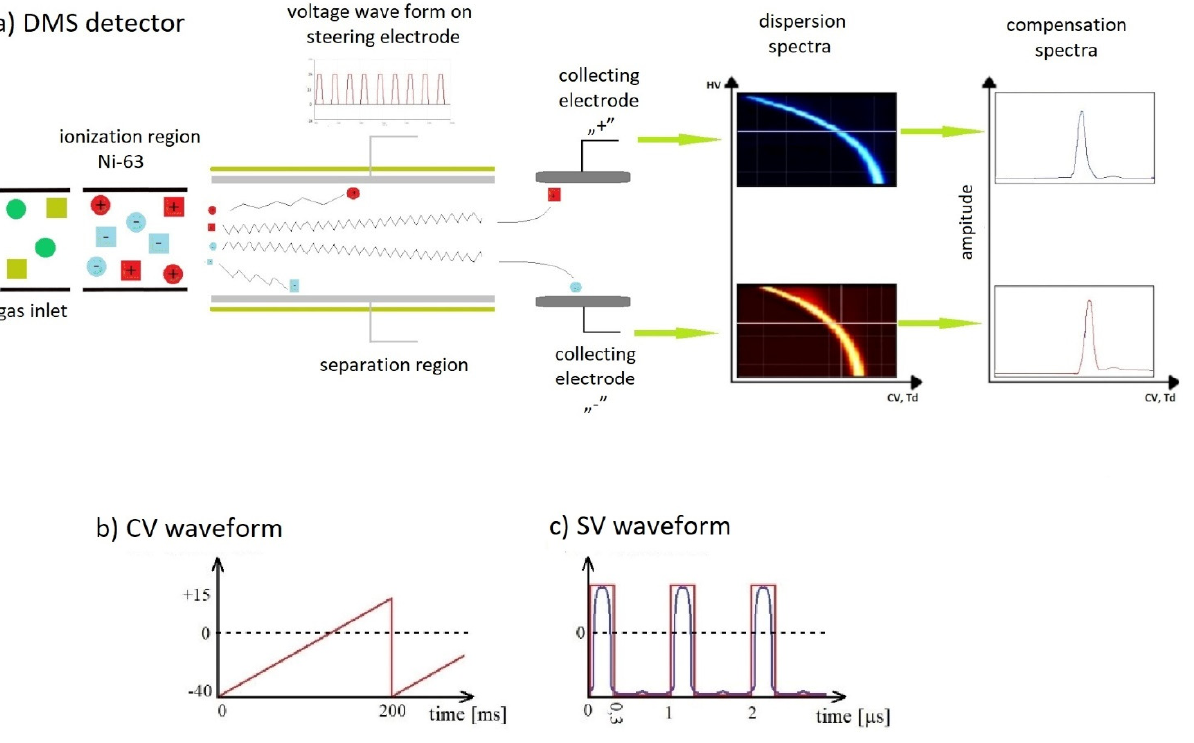
Figure 1. Scheme of a differential ion mobility spectrometer: ( a ) general scheme of the DMS spec- trometer, and routes of ionized positive and negative species; ( b ) CV waveform; ( c ) SV waveform. In the DMS detector, an introduced carrier gas and a sample are ionized with the Ni-63 ionizing source. Next, the carrier gas and the sample enter the separation region, where ions are separated by the influence of the changing electric field. This field is created by applying changing voltage to one of the electrodes. This voltage is the sum of a slow- varying saw-tooth waveform with a frequency of a few hertz (compensation voltage; CV) and a quasi-rectangular waveform voltage with a duty cycle of ~30% and a frequency of ~1 MHz (separation voltage; SV). The second electrode is held at zero potential. The field